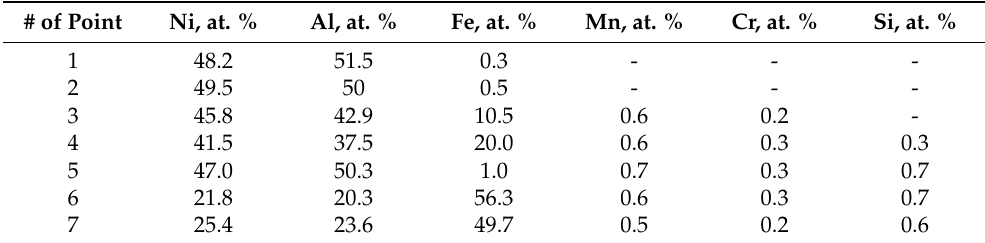
Table 4. EDX analysis at local points in Figure